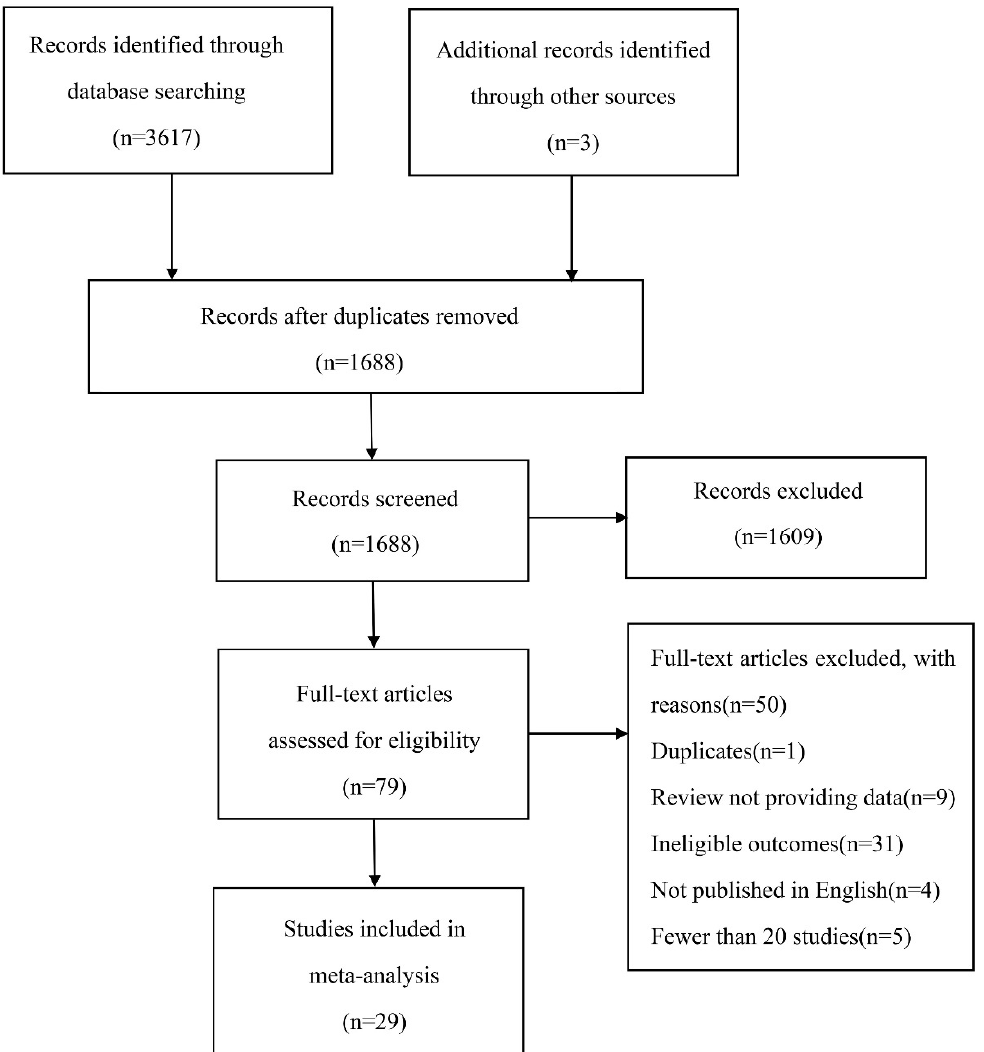
Figure 1. The flow diagram of study selection.